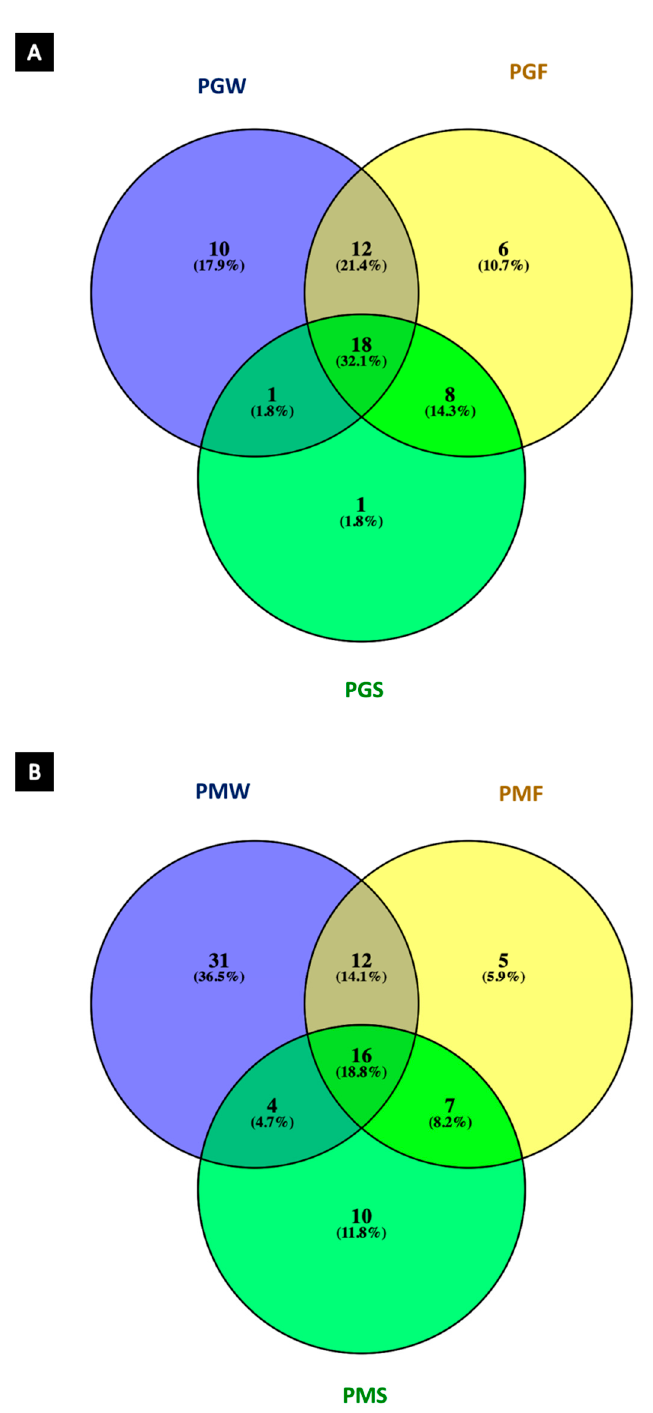
( A ) Piper gaudichaudianum wild (PGW), first (PGF) and second (PGS) generations and( B ) Pipermollicomum Figure 1. Venn diagram achieved from the constituents of the essential oil in the leaves of ( A ) Piper wild (PMW), first (PMF) and second (PMS) gaudichaudianum wild (PGW), first (PGF) and second (PGS) generations and ( B ) Piper mollicomum wild (PMW), first (PMF) and second (PMS) generations.